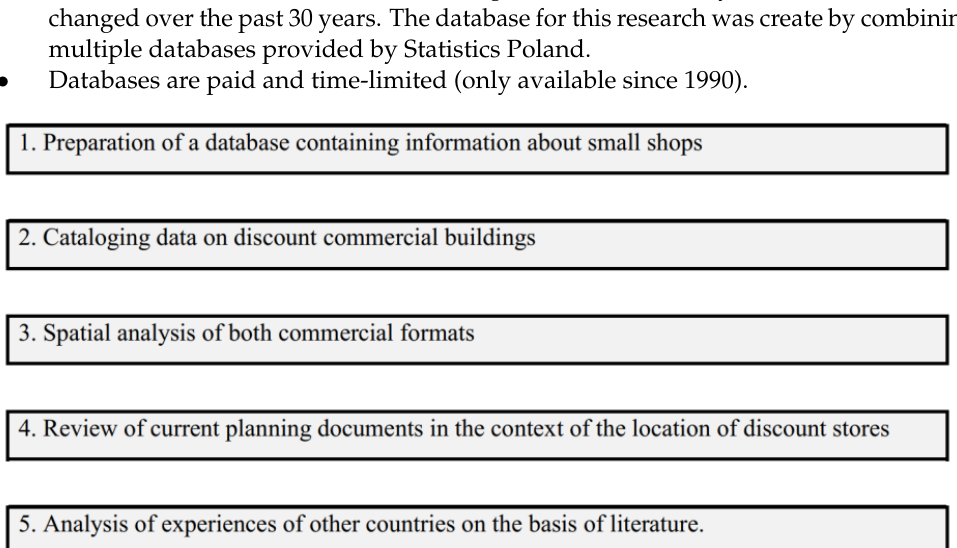
Figure 1. Methodological flow chart.